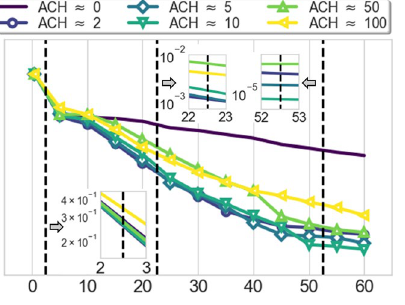
Figure 27. Total mass of airborne droplets under various